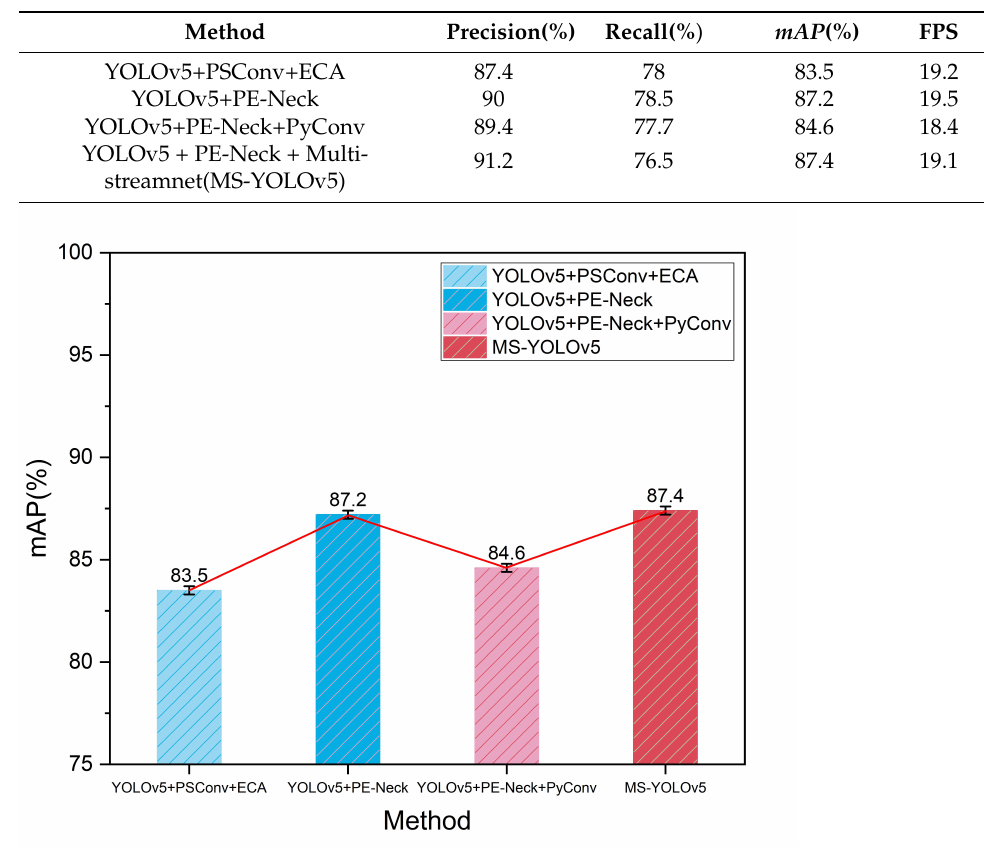
Table 3. Performance comparsion of ablation study.